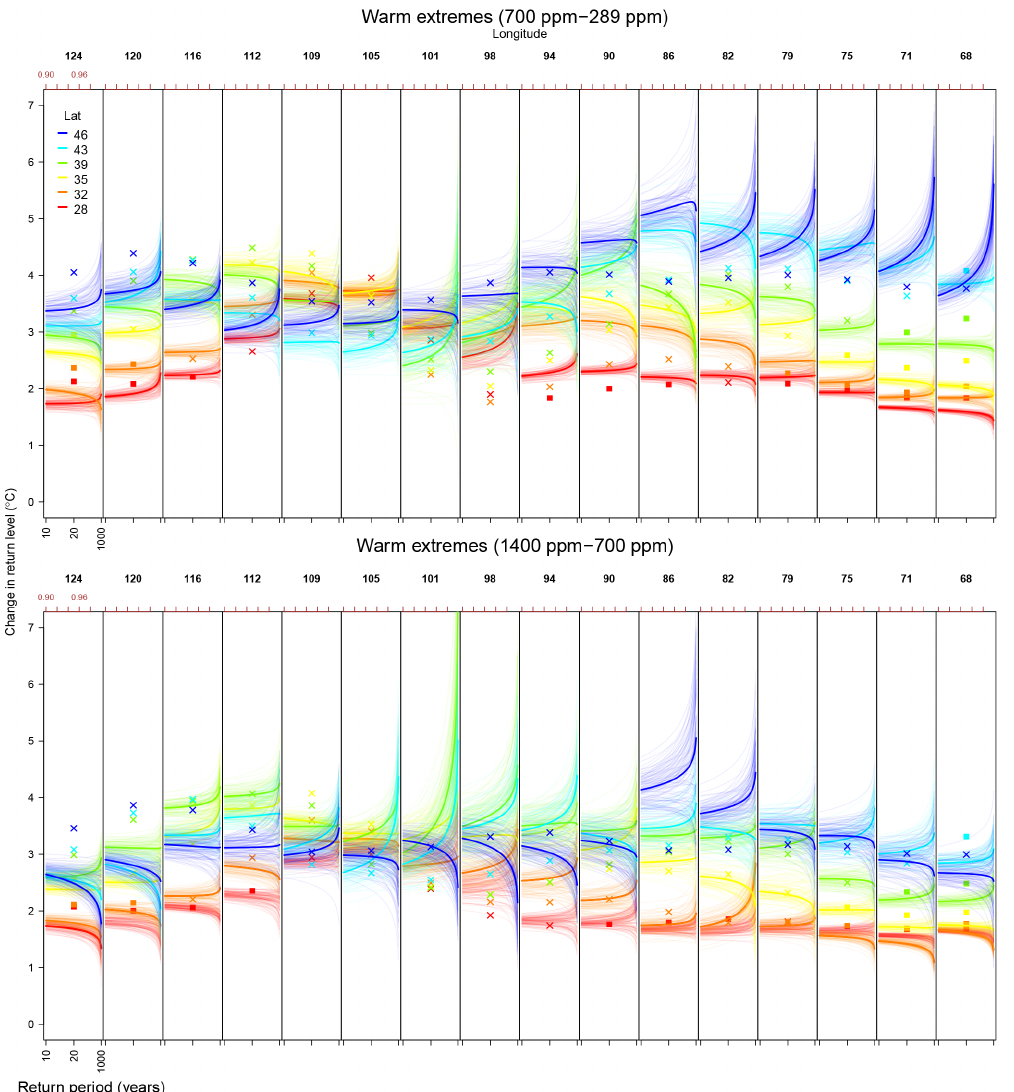
Figure 7. Estimated changes in warm extremes return levels for possible future climate conditions in our CCSM3 runs. Top: 700ppm CO 2 vs. 289ppm CO 2 climate conditions; bottom: 1400ppm CO 2 vs. 700ppm CO 2 climate conditions. Each panel shows results from the six grid cells in a longitude band, while each color represents a latitude band. Estimated changes in return levels are plotted as solid lines in their corresponding colors. Estimates obtained from block bootstrapped samples by resampling years are plotted as lighter and thinner curves to form envelopes representing the associated uncertainties. The corresponding summertime mean changes for inland and ocean grid cells are marked by cross and filled box symbols,